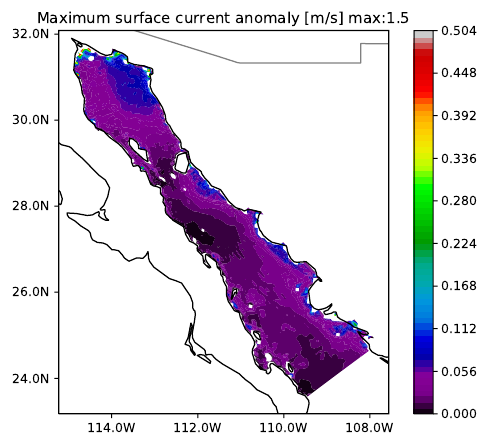
( c ) Map of the maximum anomaly recorded over the whole domain and all time steps. Figure 17. Surface current anomalies due to climatological winds. All dates in UTC.